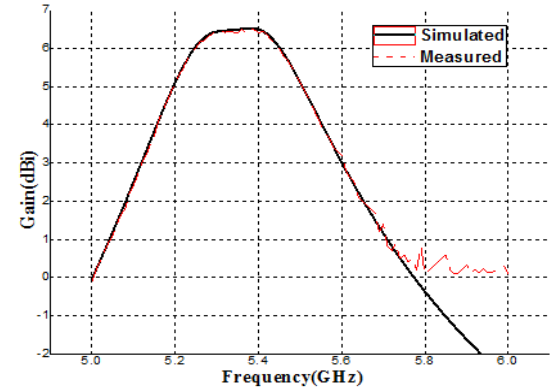
Fig. 6. The gain of the proposed antenna.